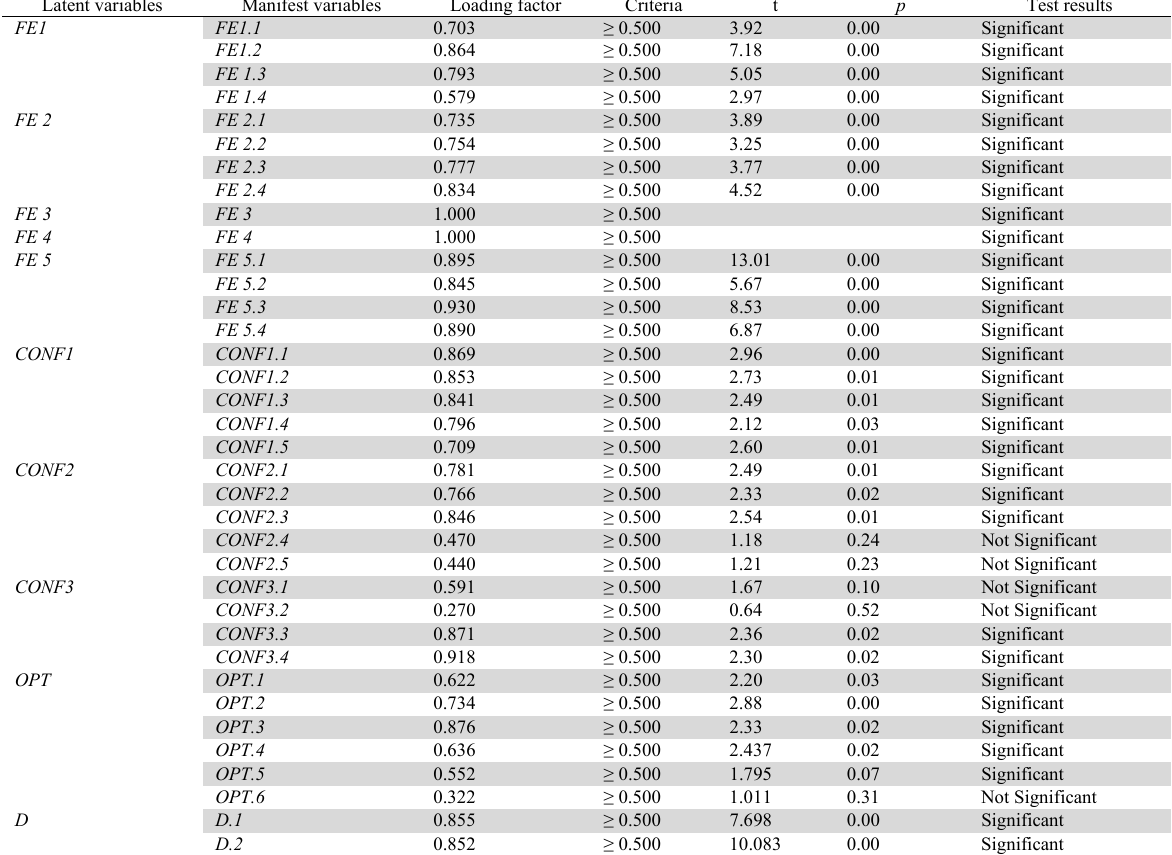
Summary of Statistical Analysis (Model I)